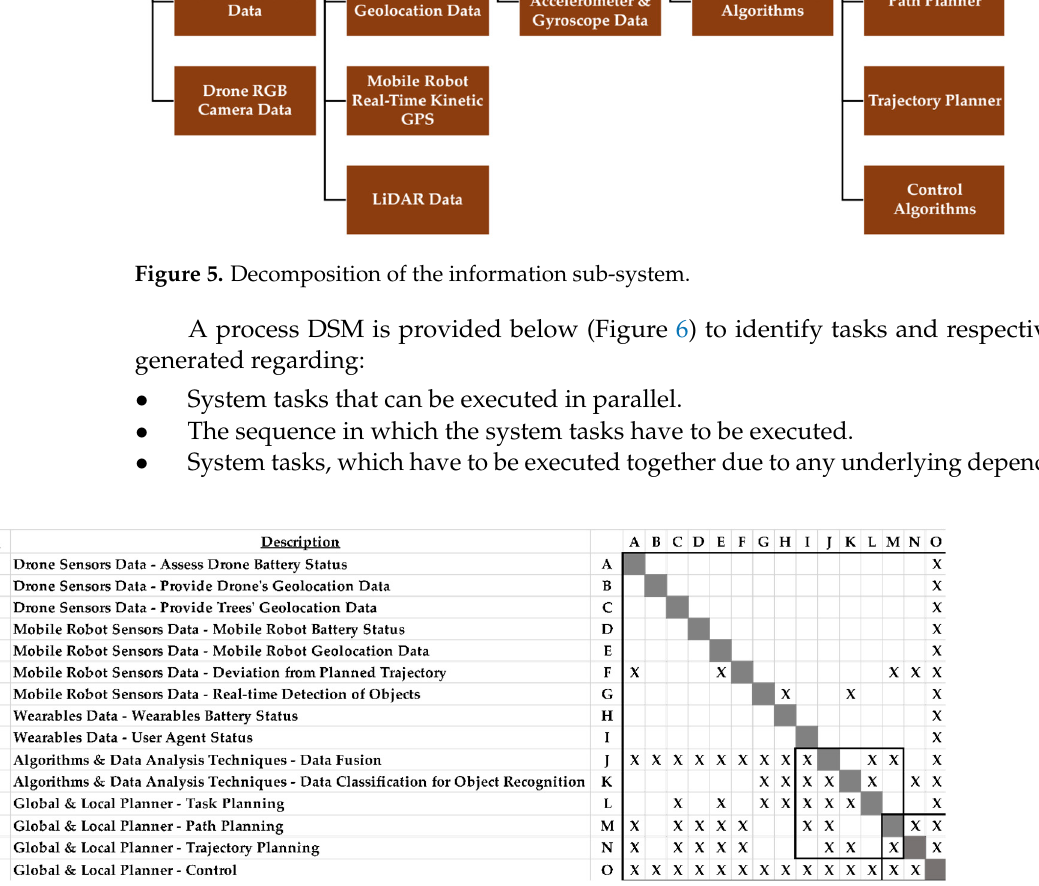
Figure 6. Process architecture DSM model of the information sub ‐ system.